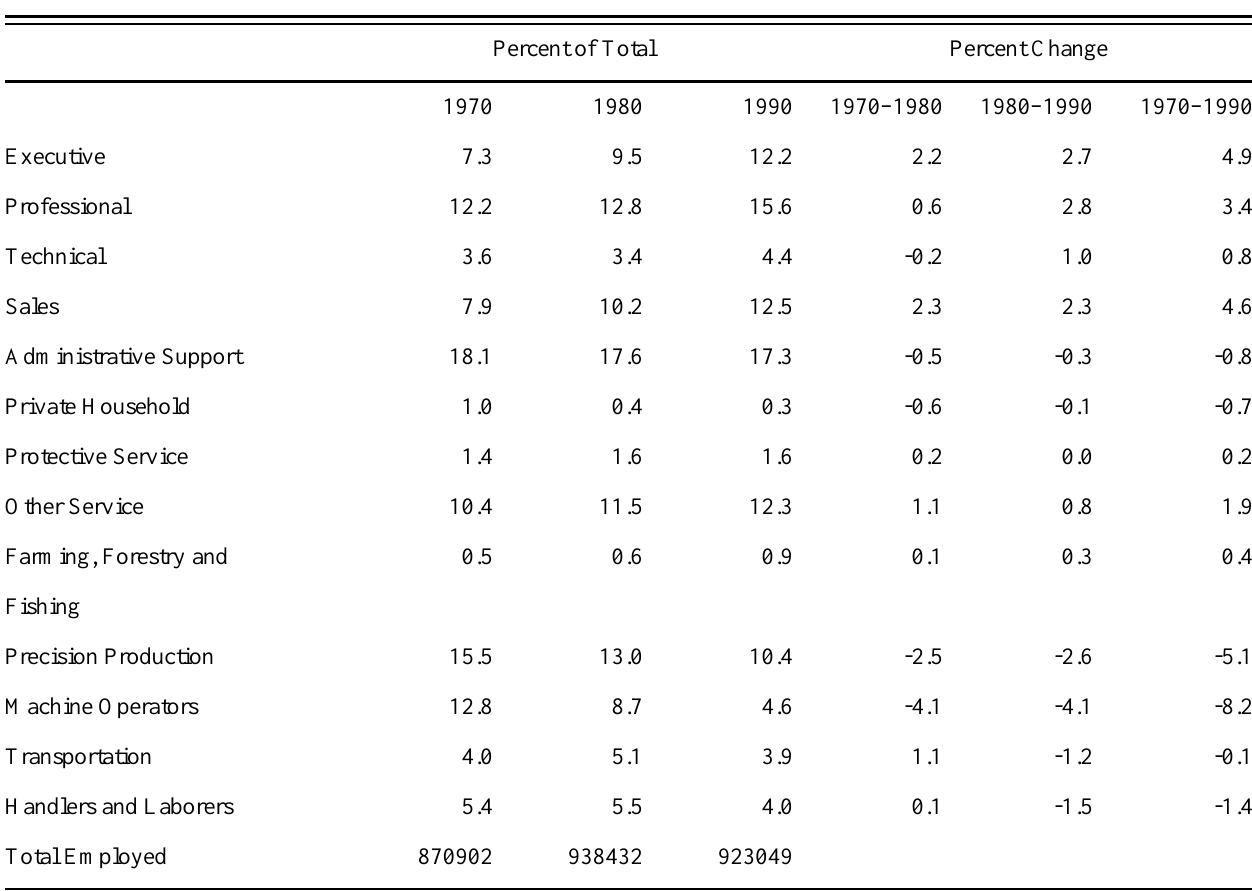
Table 4. Employment by occupation in 1970, 1980, and 1990, Pittsburgh Standard Metropolitan Statistical